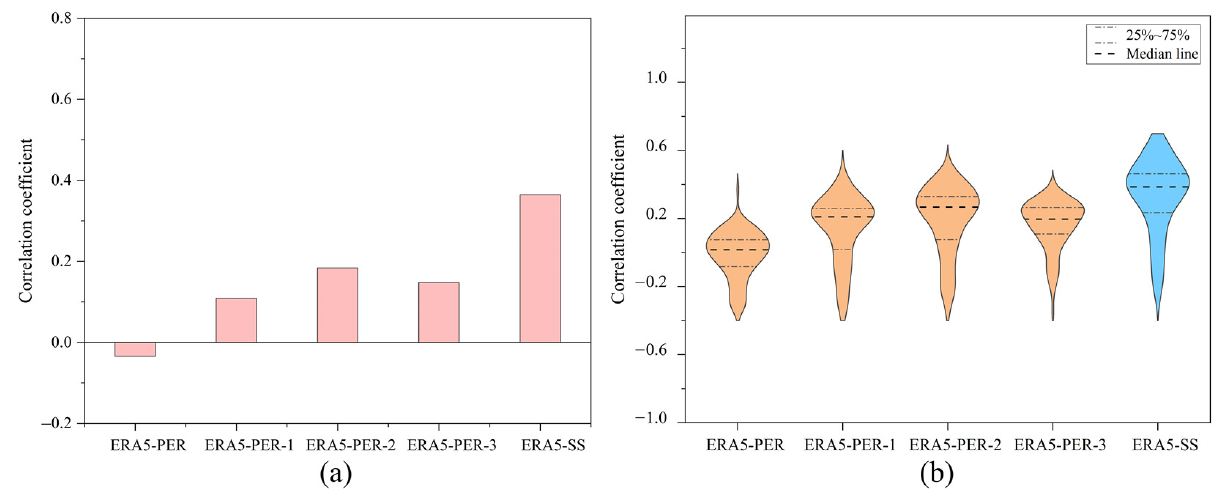
Figure 9. Time-lag effect of TWSC ( a ) and range of correlation coefficients ( b ) estimated by the PER method based on ERA5. ERA5-PER represents the correlation coefficient between TWSC estimated by the PER method based on ERA5 and results from GRACE; ERA5-PER-1 represents the correlation coefficient between TWSC estimated by the PER method based on ERA5 with a lag of 1 month and results from GRACE; ERA5-PER-2 represents the correlation coefficient between TWSC estimated by the PER method based on ERA5 with a lag of 2 months and results from GRACE; ERA5-PER-3 represents the correlation coefficient between TWSC estimated by the PER method based on ERA5 with a lag of 3 months and results from GRACE; ERA5-SS represents the correlation coefficient between TWSC estimated by the SS method based on ERA5 and results from GRACE.